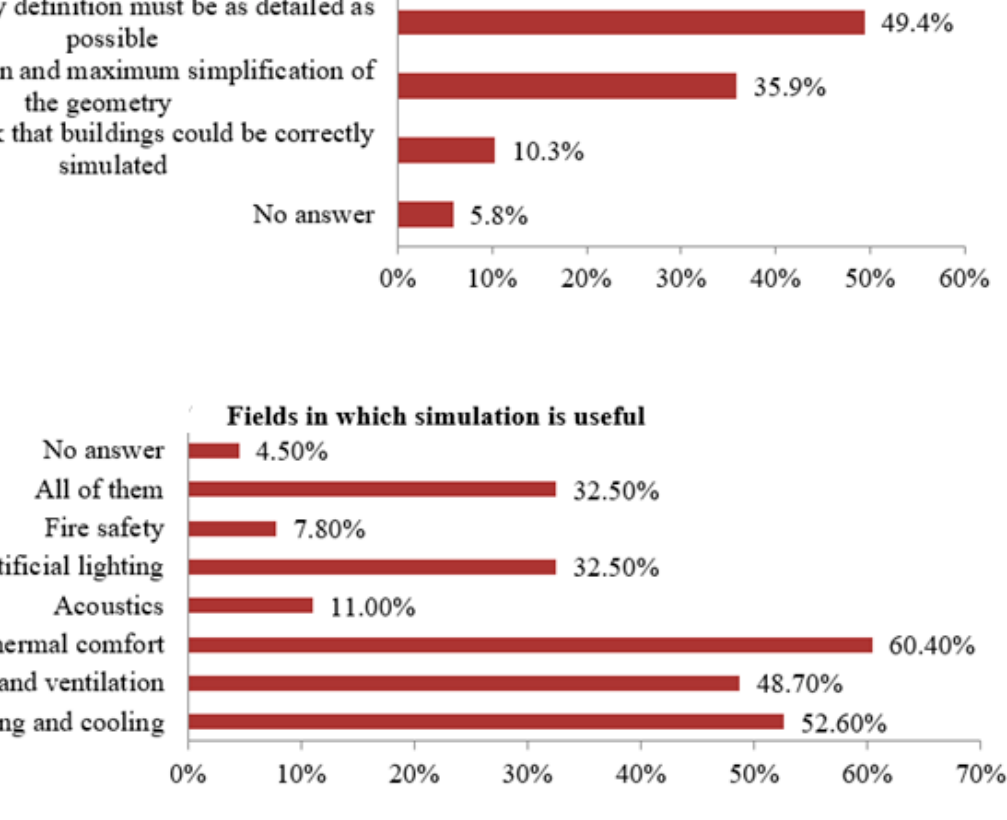
Figure 3. Opinions on how to perform a simulation.